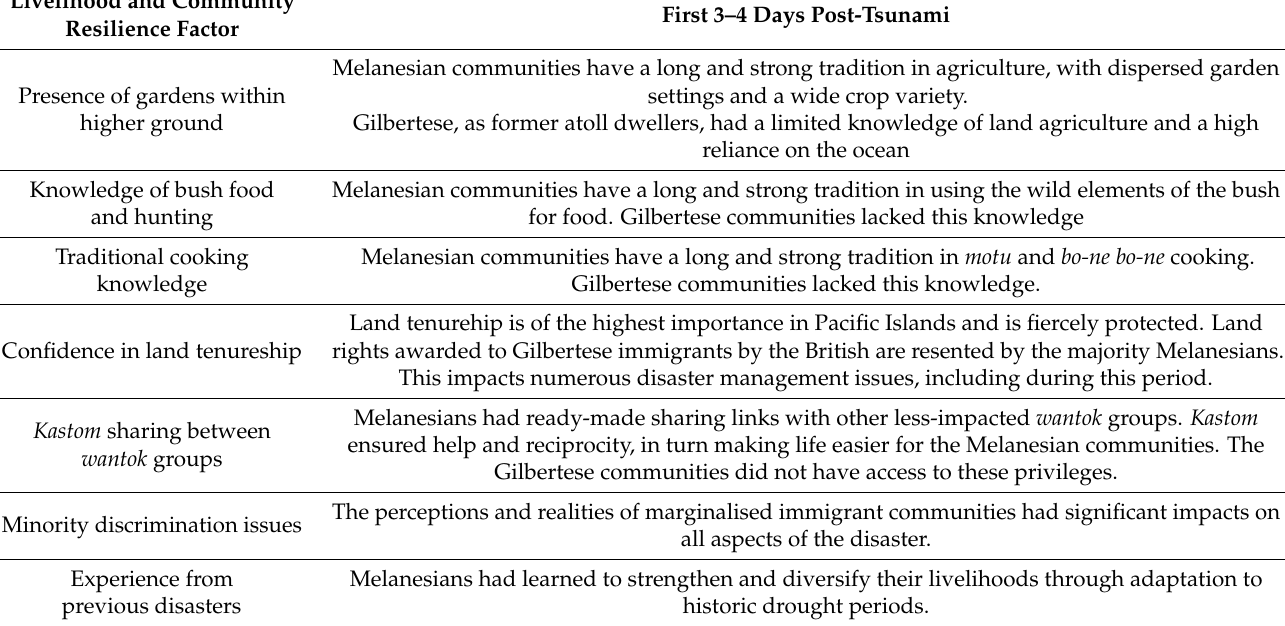
Table 6. Factors that impacted the tsunami response before aid arrived, some of which extended to all aspects of disas- ter management.